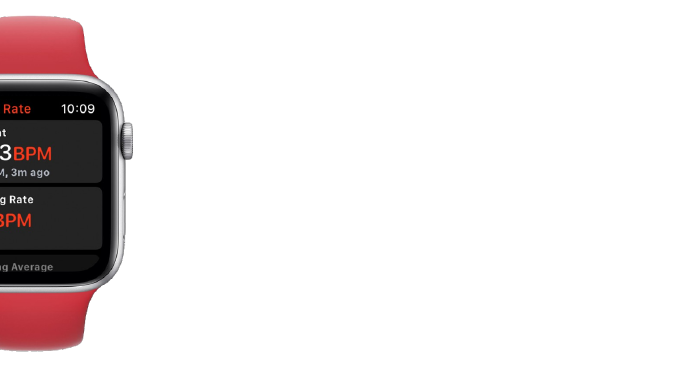
Figure 4. The smartwatch, one of the most widely used wearable